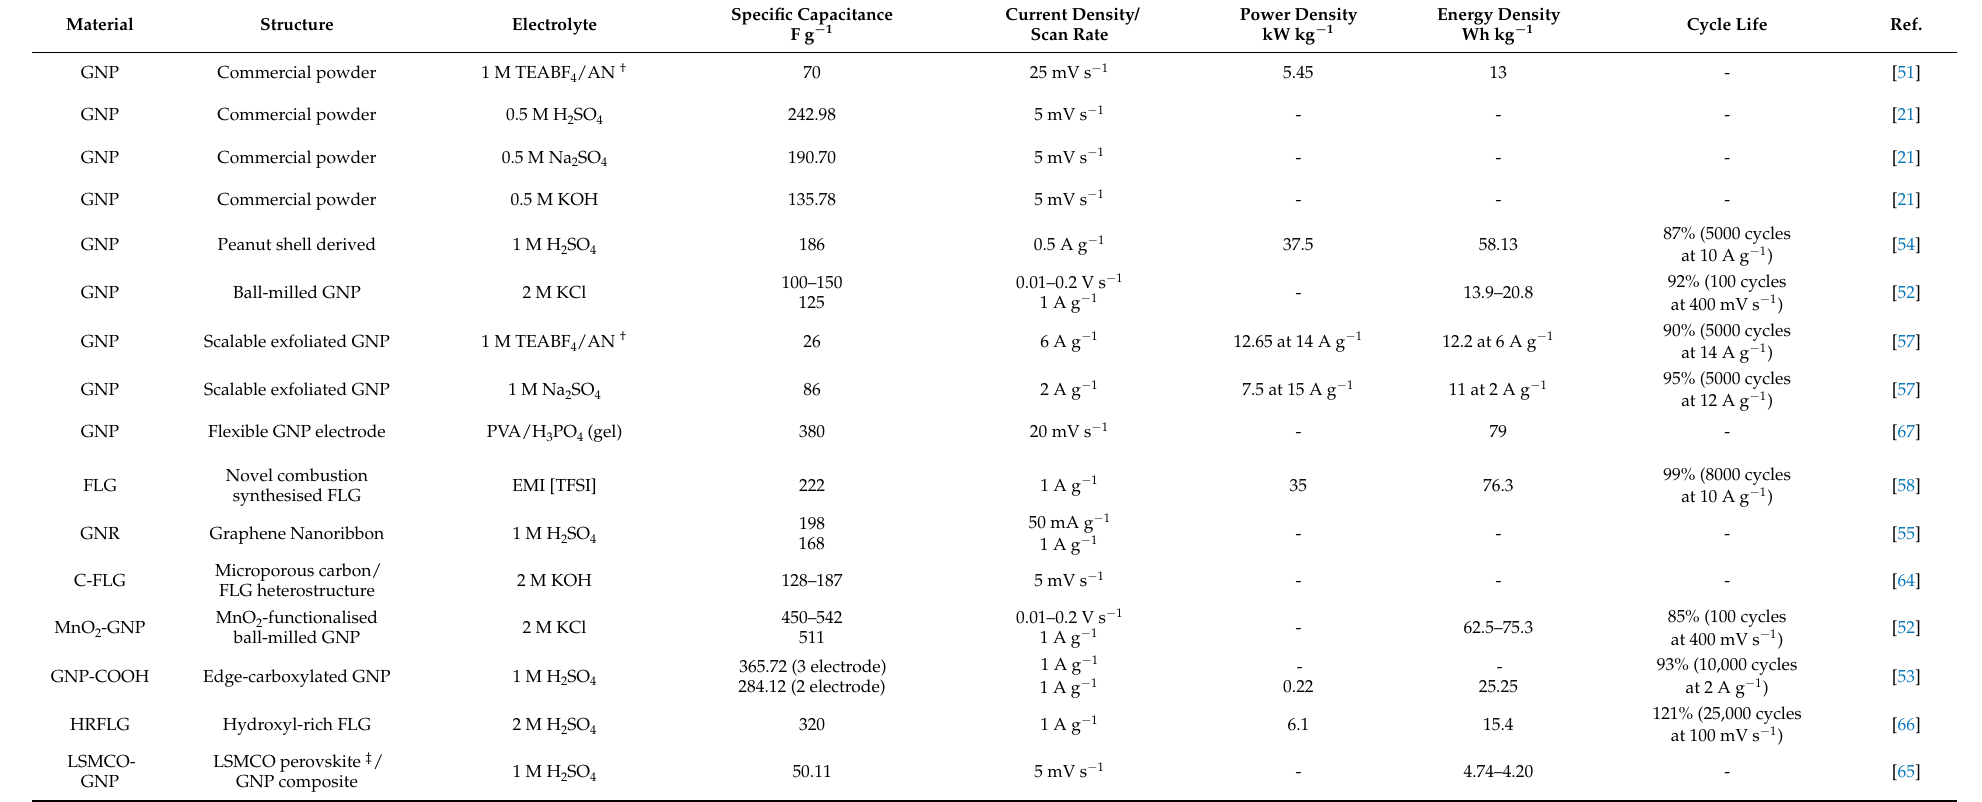
Table 1. Comparative electrochemical performance of various GNP